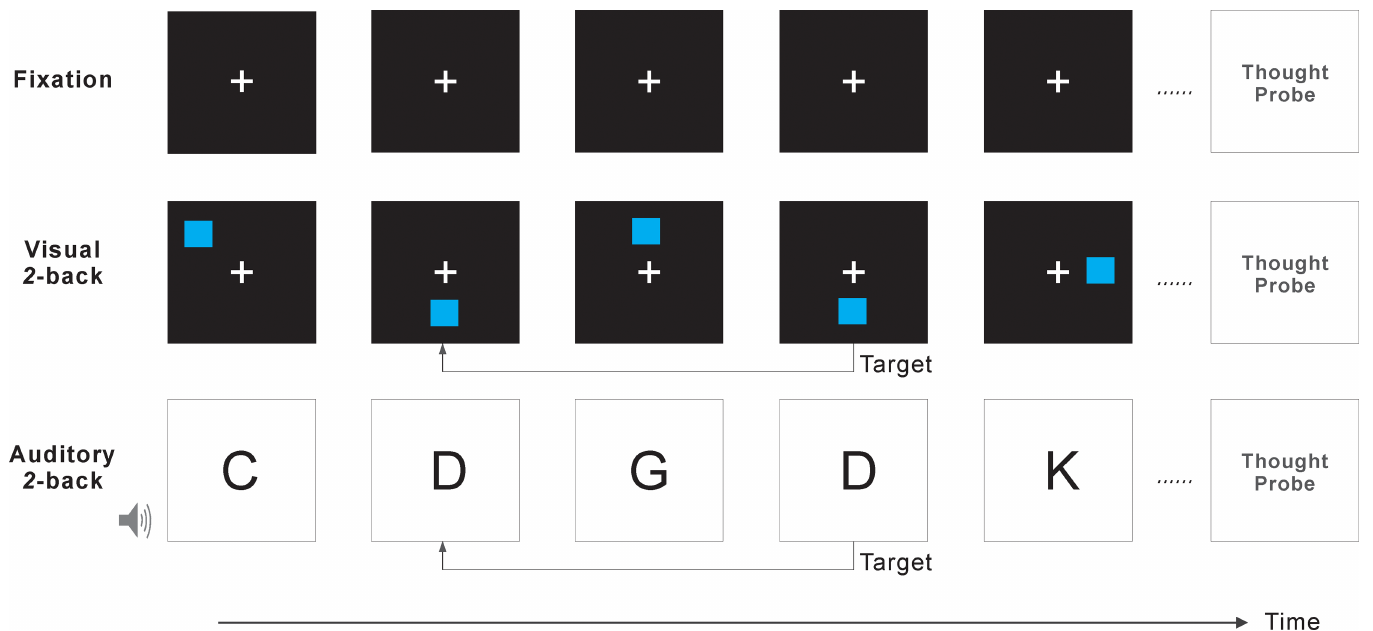
Fig 2. Illustration of the three task conditions. Fixation, visual 2-back, and auditory 2-back.